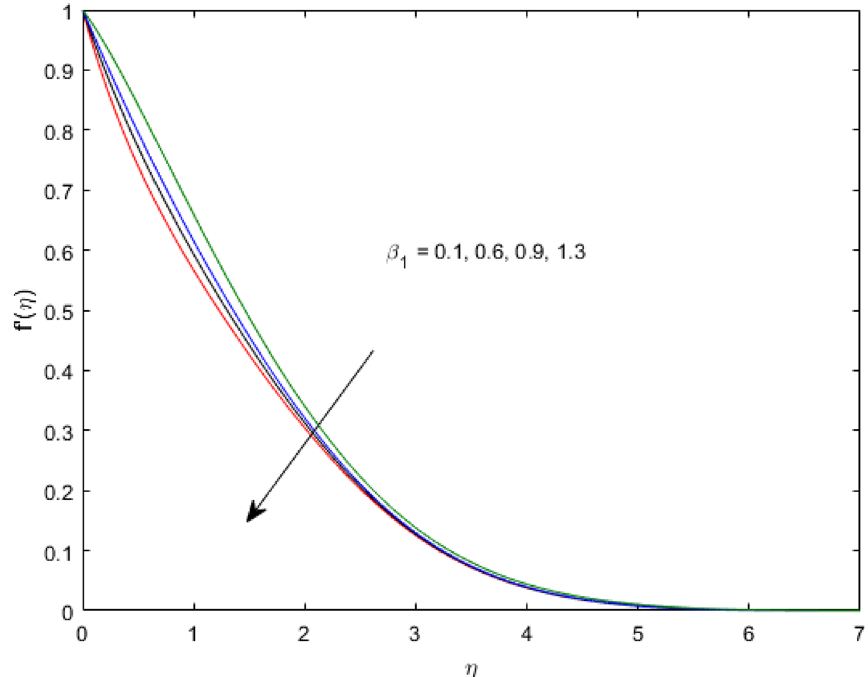
Figure 5. f ′ (η) versus varied estimates of β 1 .